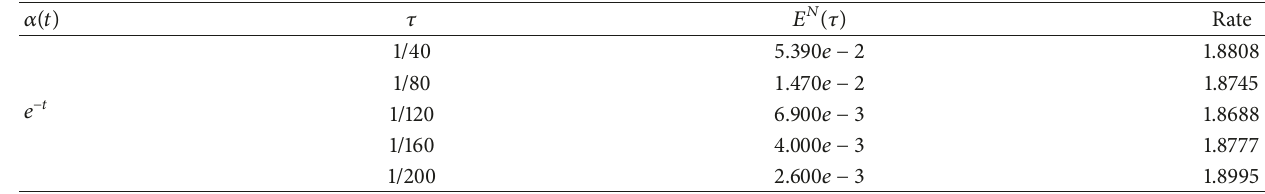
Table 6: Maximum errors and convergence rates for Example 1 at 𝑇 = 2 and 𝜎 4 = 𝜎 − 0.23 . 𝛼(𝑡) 𝜏